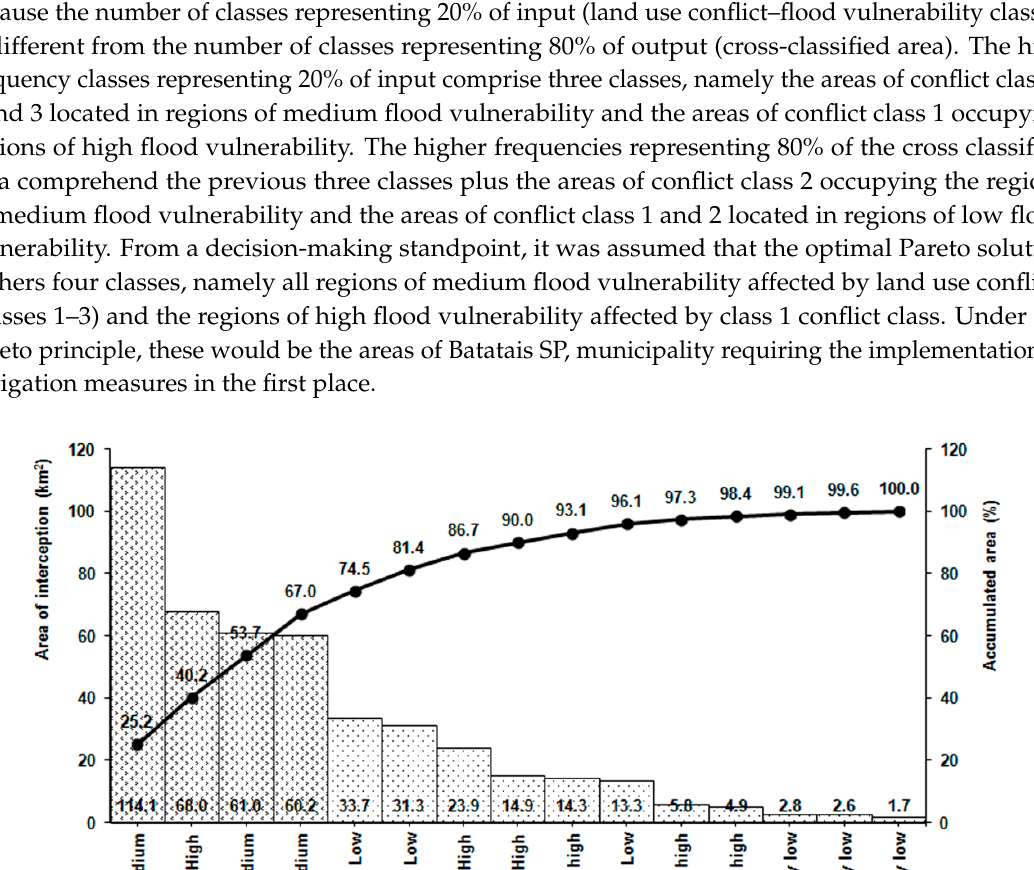
Table 7. Cross-classification of land use and flood vulnerability in the municipality of Batatais SP. The grey shaded cells represent concern situations because they correspond to medium and high flood vulnerability over large agricultural areas.